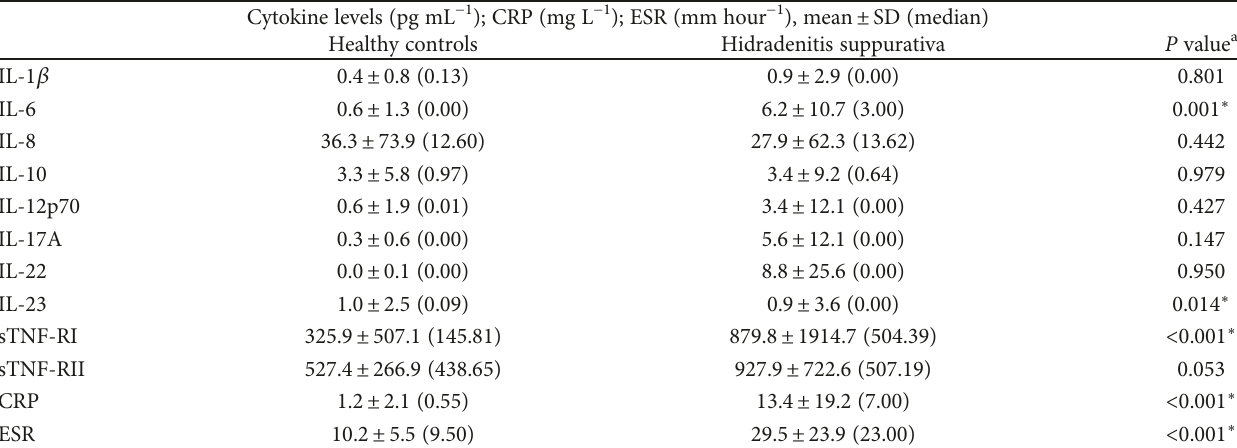
Table 2: Comparison of in fl ammatory serum marker levels among healthy controls and patients with hidradenitis suppurativa, and the results of statistical